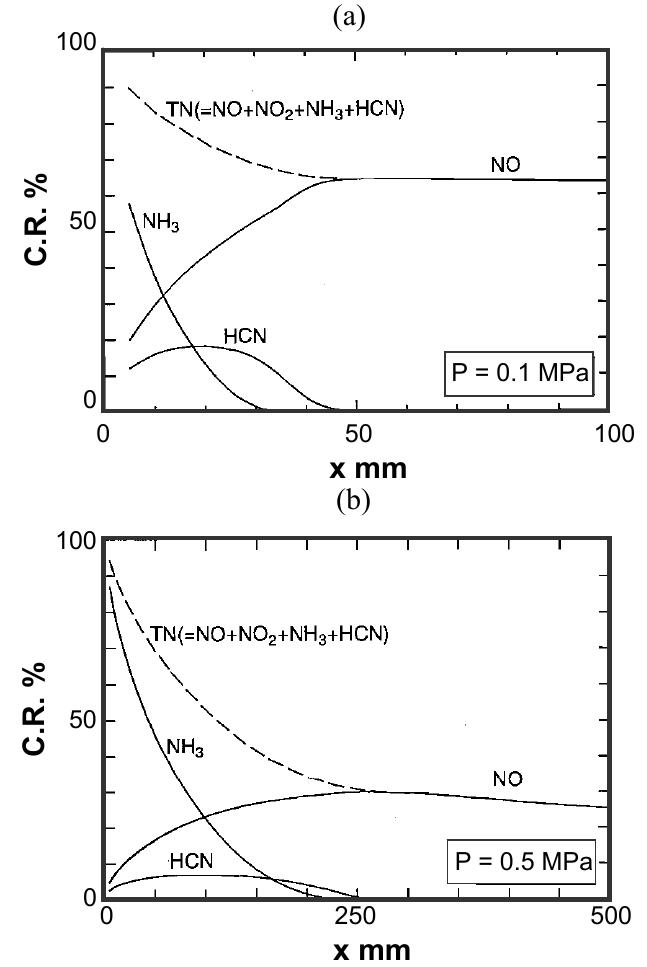
Figure 60. Axial profiles of conversion rates of NO, HCN, NH nitrogen-containing species, TN, in axisymmetric laminar flame with combustion pressure of 0.1 MPa (a) and 0.5 MPa